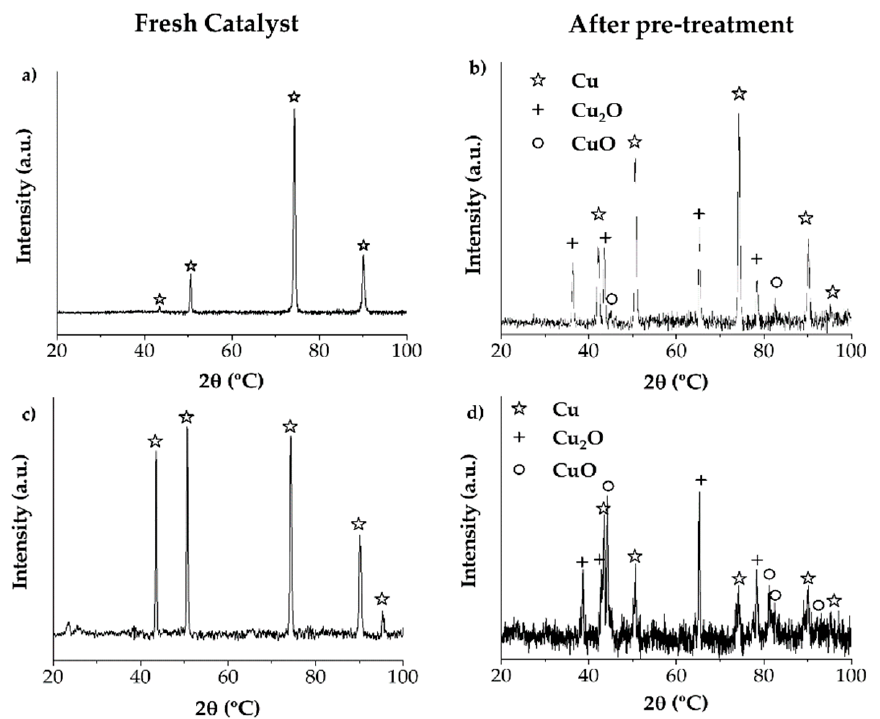
Figure 3. TPR profiles of Cu Wire and the Cu Plate.